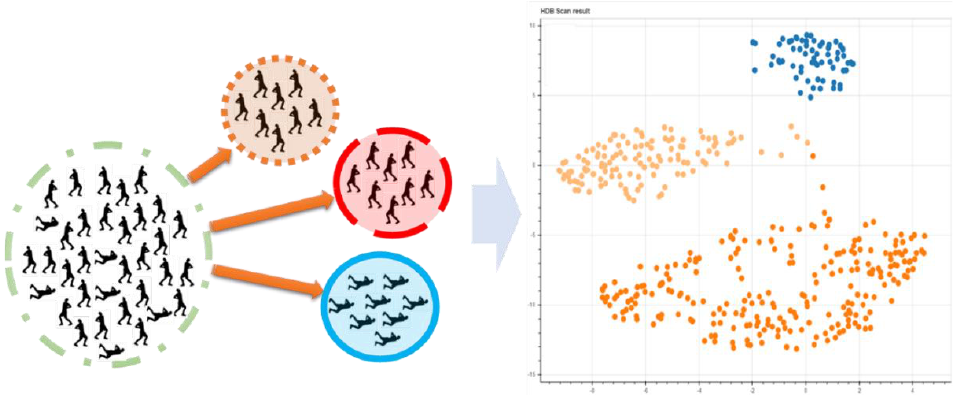
Figure 2. In unsupervised learning, patterns are searched for in a set of data and applied to form data